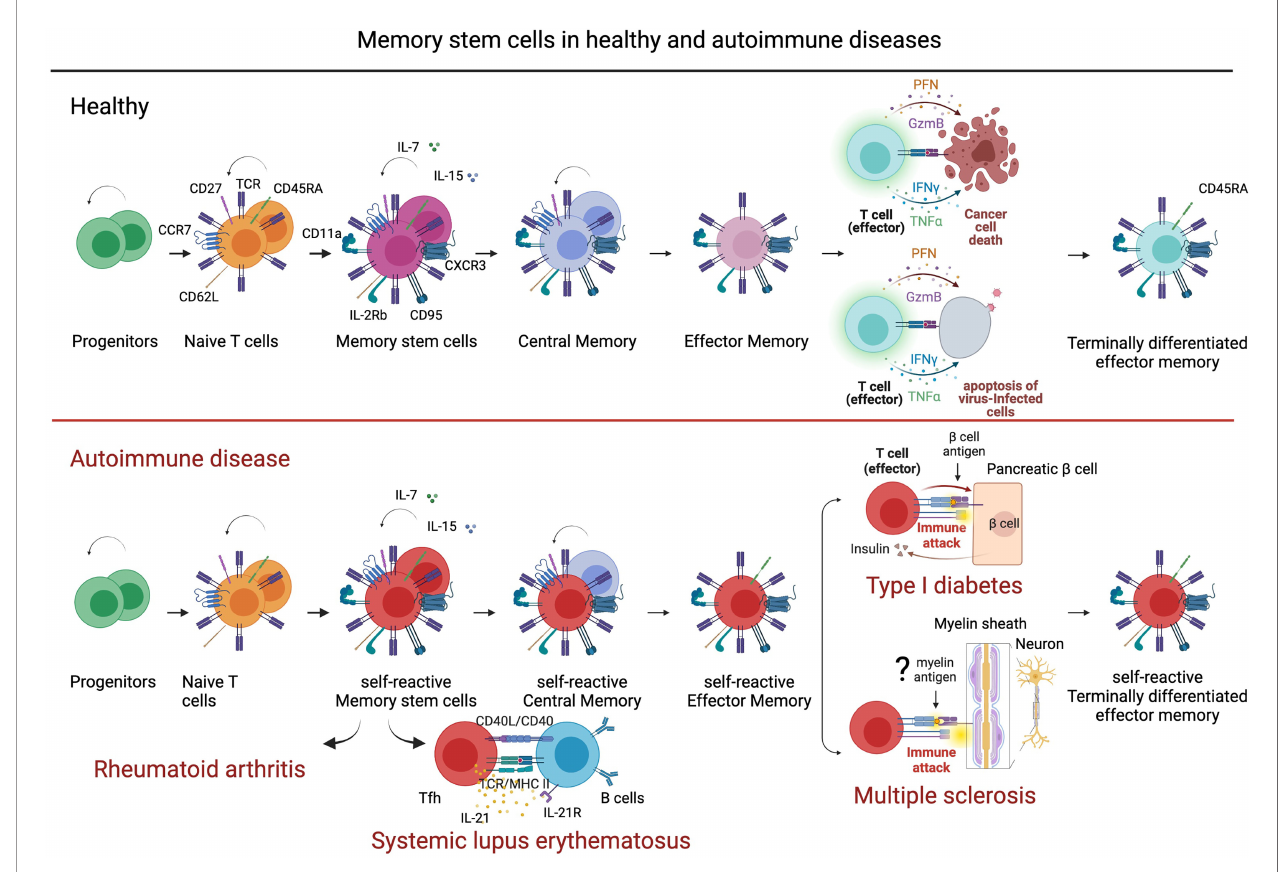
FIGURE 2 | Stem memory cells in healthy and autoimmune disease. Stem memory cells constitute a subset of T cells with self-renewal and multipotent capacity. Generated from naïve cells, stem memory cells develop into memory subsets including central memory and effector memory. Stem memory cells express a naïve-like phenotype (CD45RA + , CCR7 + , CD62L + , CD27 + , CD28 + , and IL7Ra + ) and memory markers (CD95 + , CXCR3 + , IL-2Rb + , CD58 + , and CD11a + ), which vary during further differentiation. While essential to immunological memory in healthy immune system, memory stem cells also represent a reservoir of autoreactive clones in autoimmune disease. For example, in type I diabetes (TDI) self-reactive b -cell-speci fi c CD8 T cells maintain a memory stem cell phenotype that favors a persistent production of pathogenic clones. In systemic lupus erythematosus, memory stem cells differentiate easily into T follicular helper cells (Tfh) that contribute to B cell differentiation and antibody production. In multiple sclerosis, stem memory cells recognizing, hypothetically, myelin antigens could represent a supply of pro- in fl ammatory and cytotoxic cells targeting myelin and damaging neurons. Figure created with